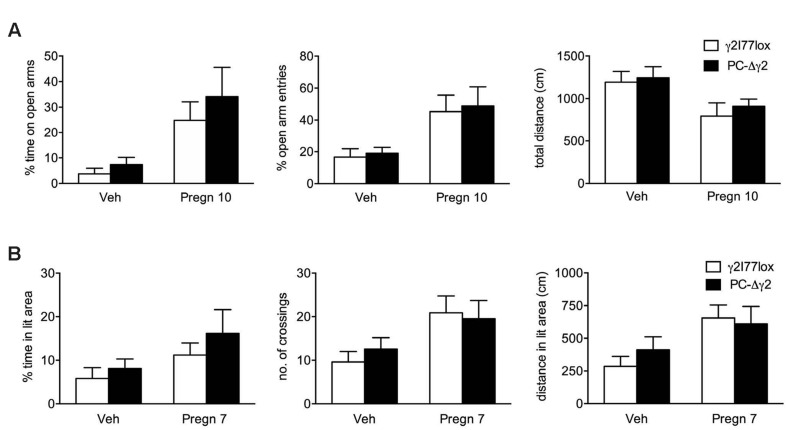
Effects of pregnanolone on PC-Δγ2 mice with targeted inactivation of GABAA receptor γ2 subunit gene in the cerebellar Purkinje neurons in tests for anxiety and exploration. The γ2I77lox and PC-Δγ2 mice were treated with vehicle or pregnanolone (at doses indicated below the bars, in mg/kg i.p.) and 15 min later tested in the elevated plus maze (A) and light:dark exploration (B) tests. The results (means ± SEM, n = 7–9 per group) show no differences between mouse lines (two-way ANOVA, P > 0.1), but significant effects by the treatment in both tests for all measures (P < 0.013), except for the % time in the lit area (P = 0.07).